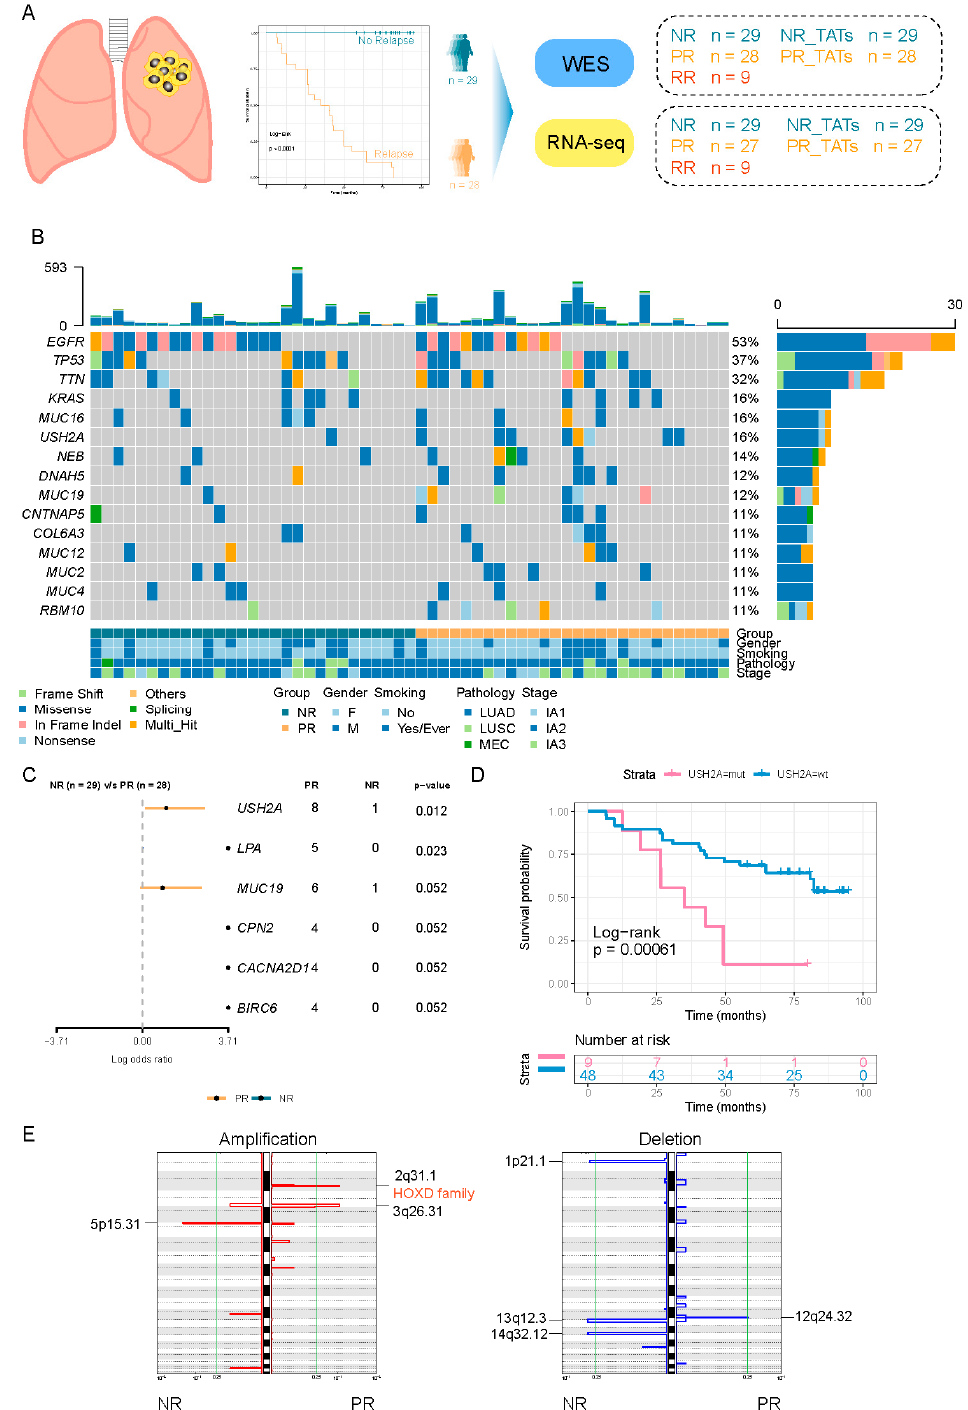
Figure 1. The difference of genetic characteristics between PR and NR. ( A ) Schematic diagram of the study design. ( B ) Oncoprint showing the mutations of the top 15 most frequently mutated genes. The upper barplot shows the mutation burden of each patient. The bottom annotation shows the clinical features (tumor stage, smoking, and gender). ( C ) Forest plot comparing the frequency of genes mutated in PR versus that mutated in NR. Enrichment for each gene was determined by using a two-tailed Fisher’s exact test. Only genes with a p -value < 0.1 are shown. ( D ) Kaplan–Meier curve for DFS of USH2A mutant and USH2A wild-type group. Log-rank test was used to compare the difference. ( E ) GISTIC 2.0 was used to detect significantly altered region with amplification (red) and deletion